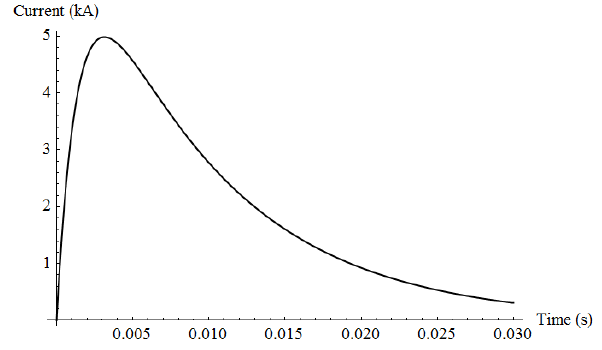
Figure 10: Sprite current with